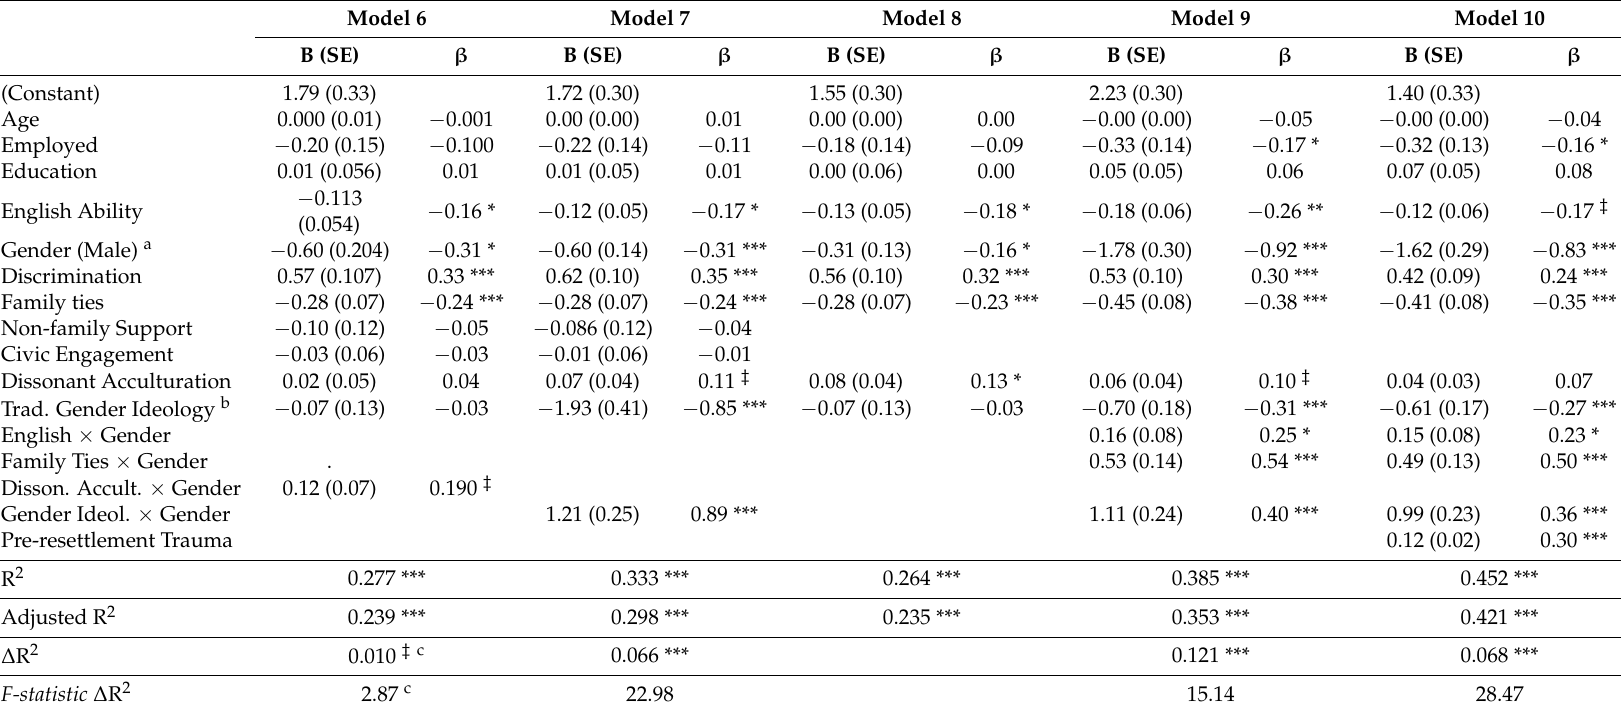
Table 3. Resettlement factors and factors moderated by gender explaining psychological distress